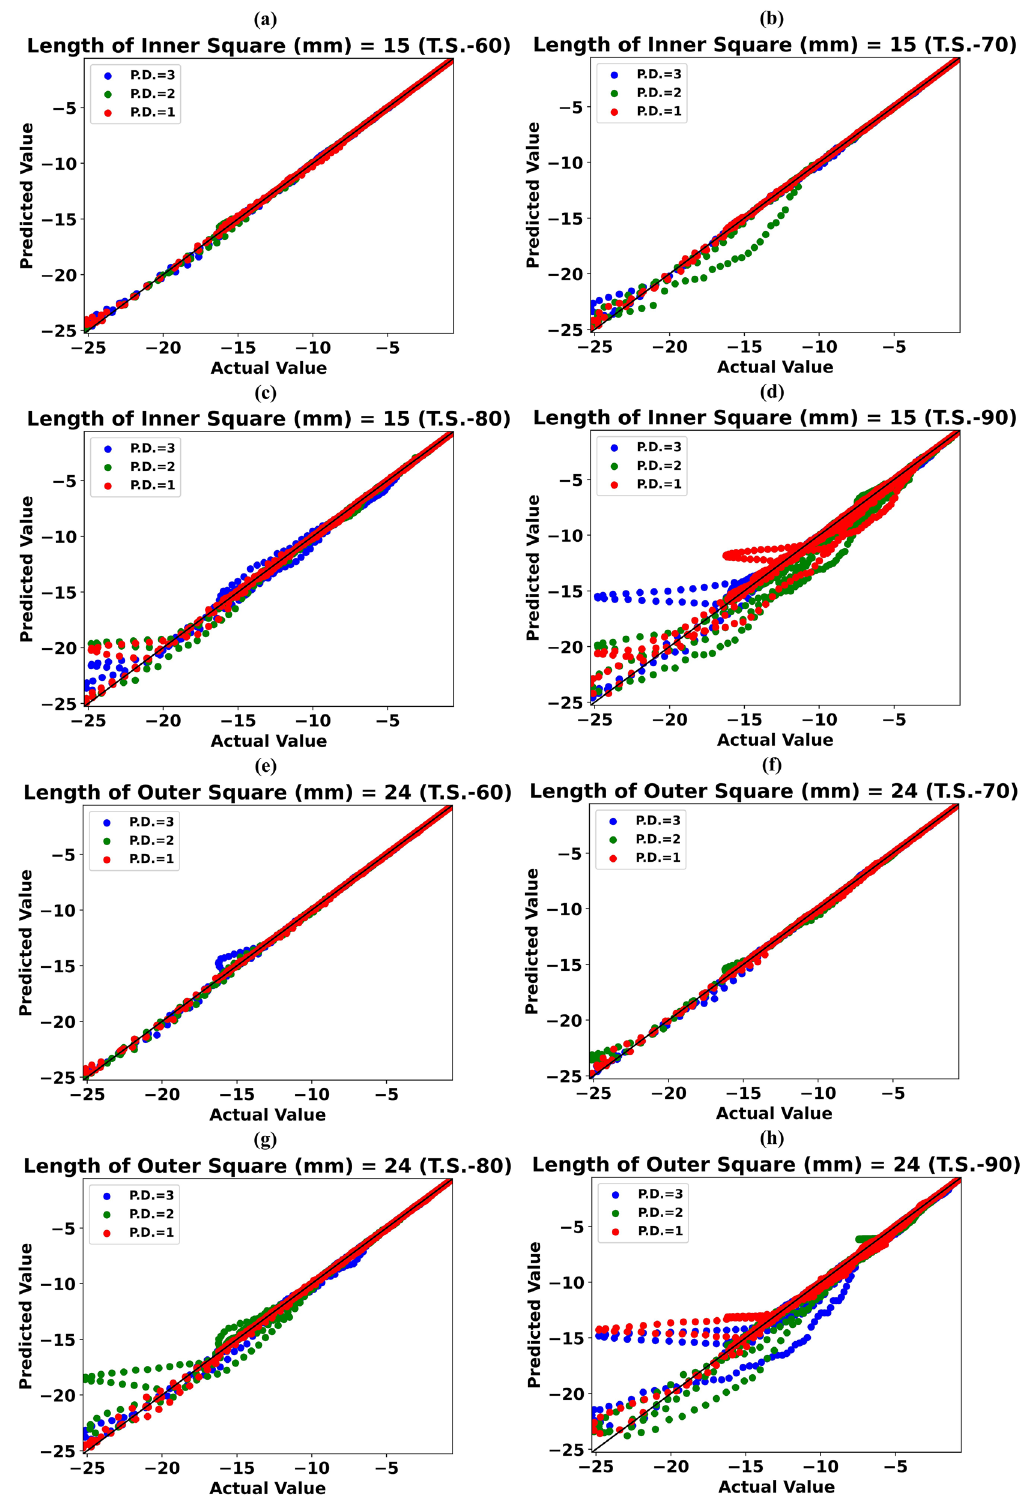
Figure 7. Scattergram of the Predicted value of reflectance vs Simulated value of reflectance for ( a ) Length of Inner Square (LIS) = 15 mm during T.S.-60 ( b ) LIS = 15 mm during T.S.-70 ( c ) LIS = 15 mm during T.S.-80 ( d ) LIS = 15 mm during T.S.-90 ( e ) Length of Outer Square (L0S) = 24 mm during T.S.-60 ( f ) L0S = 24 mm during T.S.-70 ( g ) L0S = 24 mm during T.S.-80 ( h ) L0S = 24 mm during